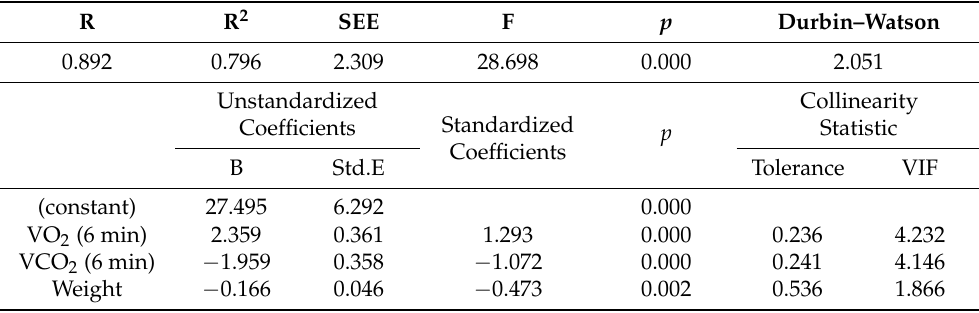
Table 3. Multiple linear regression analysis to estimate arm ergometer VO 2 max based on anthropo- metric and physiological variables.